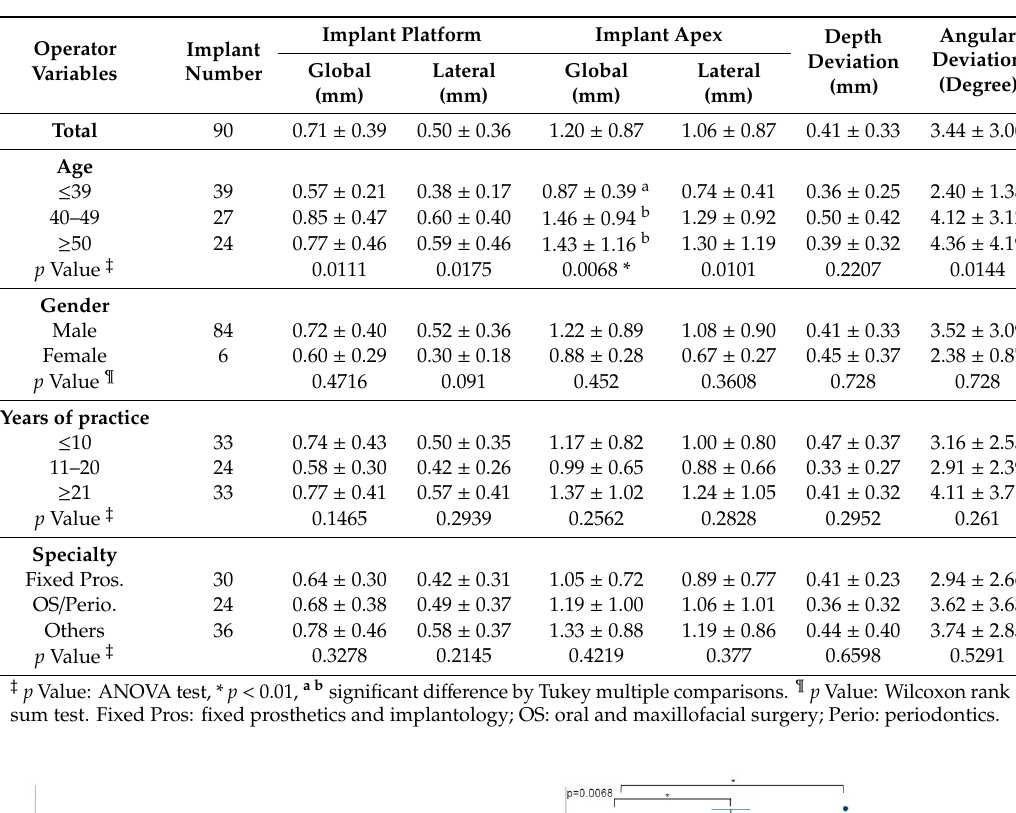
Table 4. Deviations between planned and placed implant position according to operator variables.